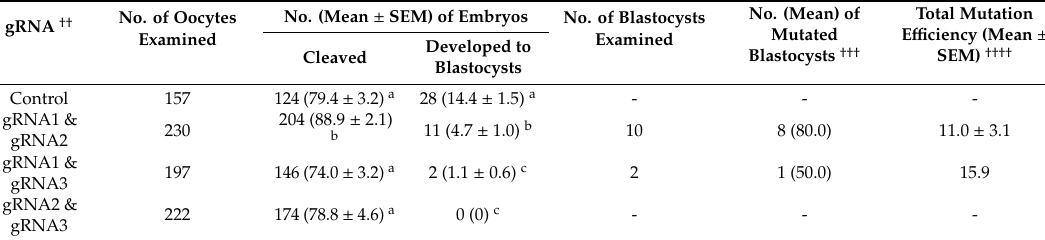
Table 2. E ff ects of gRNAs in combination targeting the PERV pol gene on the development of electroporated zygotes and mutations in the blastocysts †